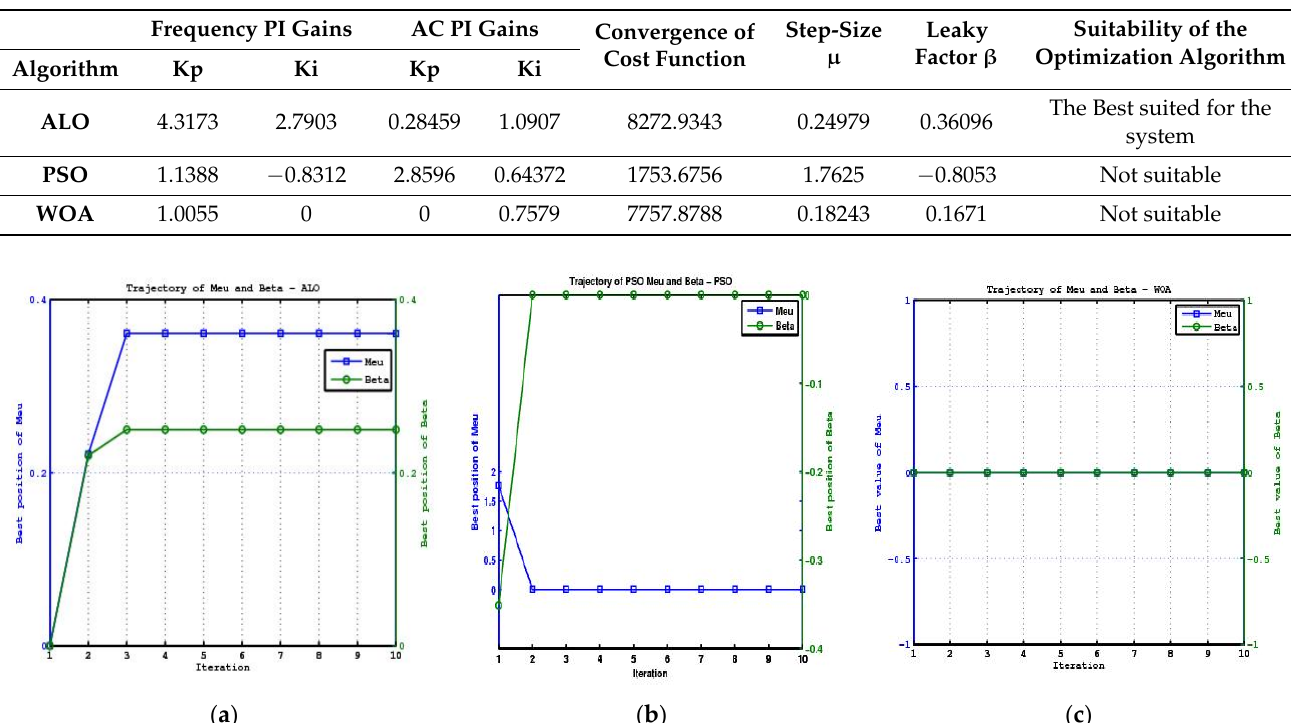
Table 1. P and I gain values, step-size and the Leaky factor as obtained from various optimization techniques.